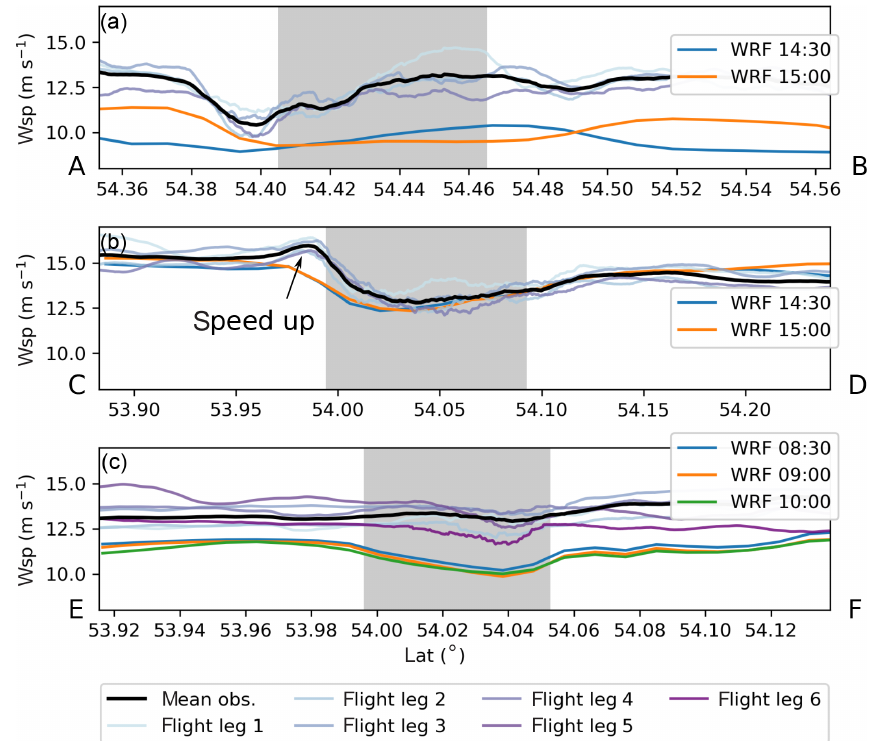
Figure 8. Observed (thin blue and purplish lines; the purple amount is increased based on how late the flight leg was flown) and simulated wind speed interpolated onto the flight track, as shown in Figs. 1 and 2 for the three case studies (a–c) as indicated in Table 1. Note the mean speed is more or less perpendicular to the flight legs (see Fig. 7a, b, c); hence, the mean wind speed points into the paper plane. The thick black line shows the mean of all wind speed measurements over the wind farms similar to the measurements shown in Fig. 7a–c. The gray shaded areas denote the location of the wind farm. The capital letters on the x axis show the orientation of the axis as indicated in Fig. 1.